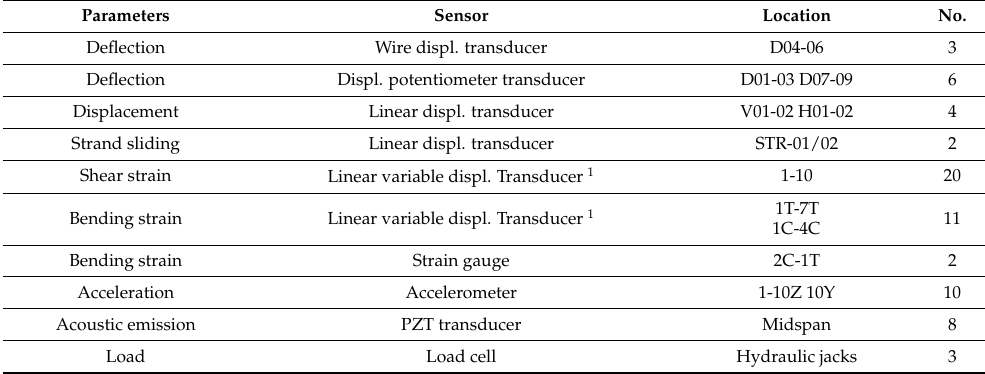
Table 3. Characteristics of the sensors’ layout.